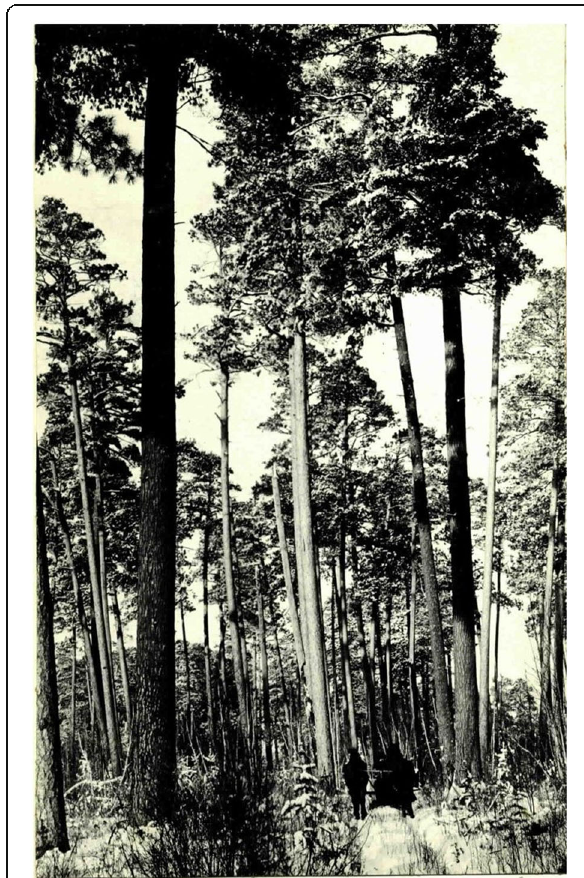
Fig. 3 Old red pine stand after a partial canopy disturbance, leaving residual live tree legacies. Circa early twentieth century, Chippewa National Forest, MN,